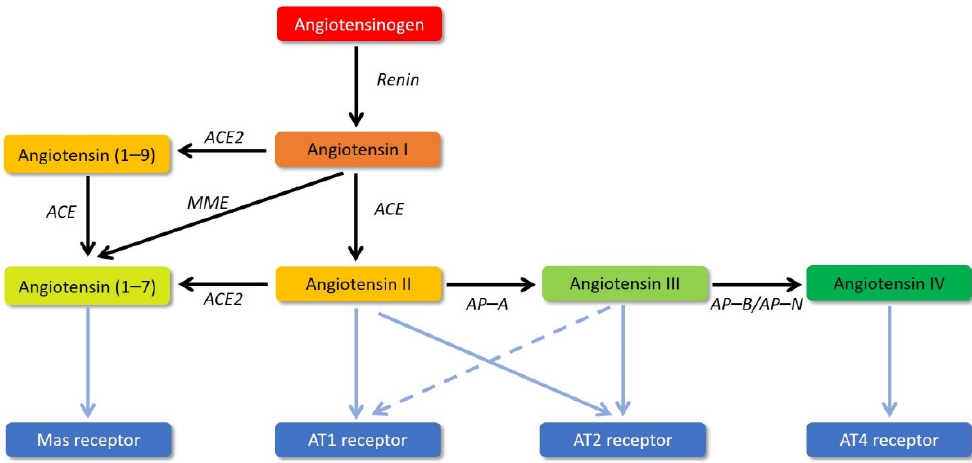
Figure 1. The renin–angiotensin system (RAS). The main effectors of the RAS, angiotensin II, angiotensin (1–7), angiotensin III, and angiotensin IV, all derivate from angiotensinogen. Each color corresponds to a conversion level. The different receptors (Mas, AT1, AT2, and AT4) are presented in blue boxes. Relations with their respective ligands are shown by blue arrows. The enzymes allowing the cleavage of the different peptides (black arrows) are written in black italics. ACE: angiotensin-converting enzyme; ACE2: angiotensin-converting enzyme 2; MME: membrane metalloendopeptidase; AP-A: aminopeptidase A; AP-B: aminopeptidase B; AP-N: aminopeptidase N.